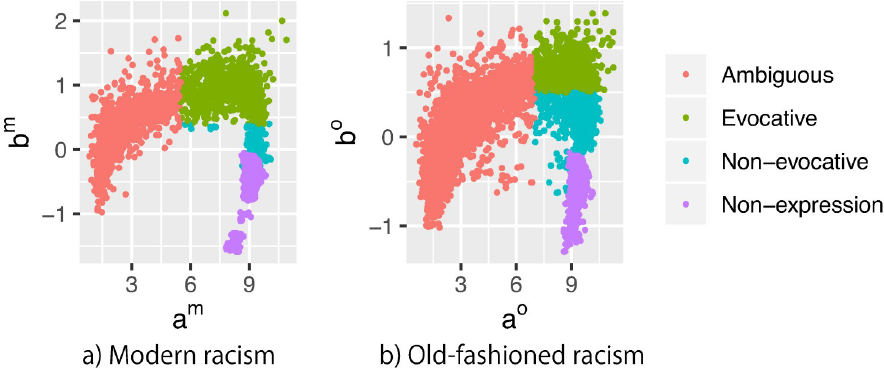
Fig 2. Scatter plots of ^ a and ^ b for modern racism (a) and old-fashioned racism (b). We classified grids as three j j clusters using threshold lines shown in S1